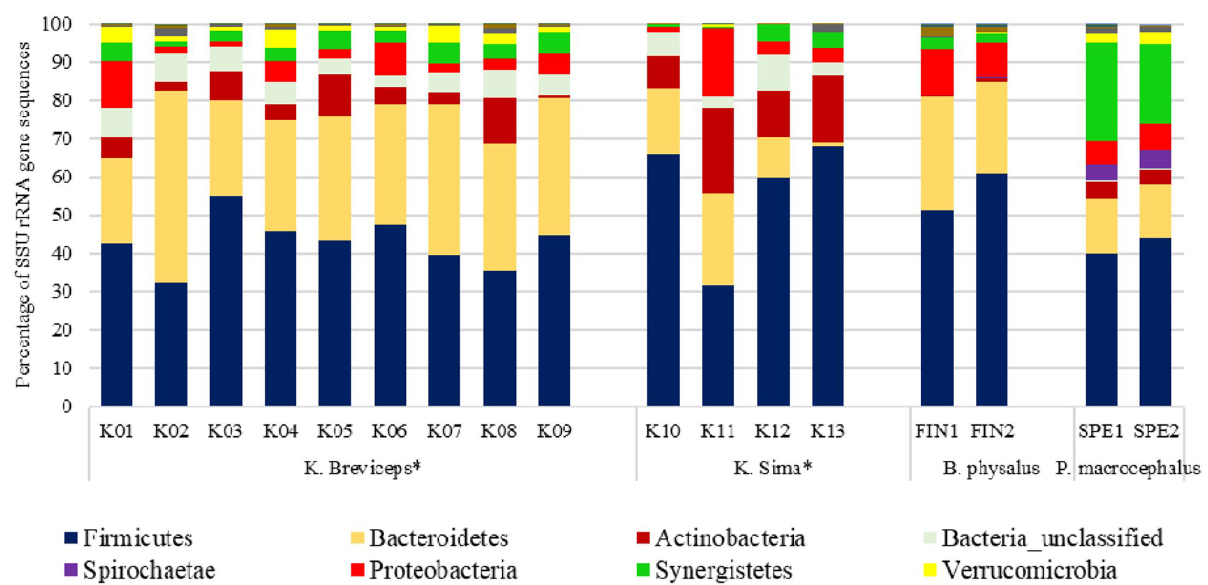
Figure 3. Phylum-level composition of gut microbiomes of whales analysed in this study, compared with previous data from other toothed whales (* data from Erwin et al. 13